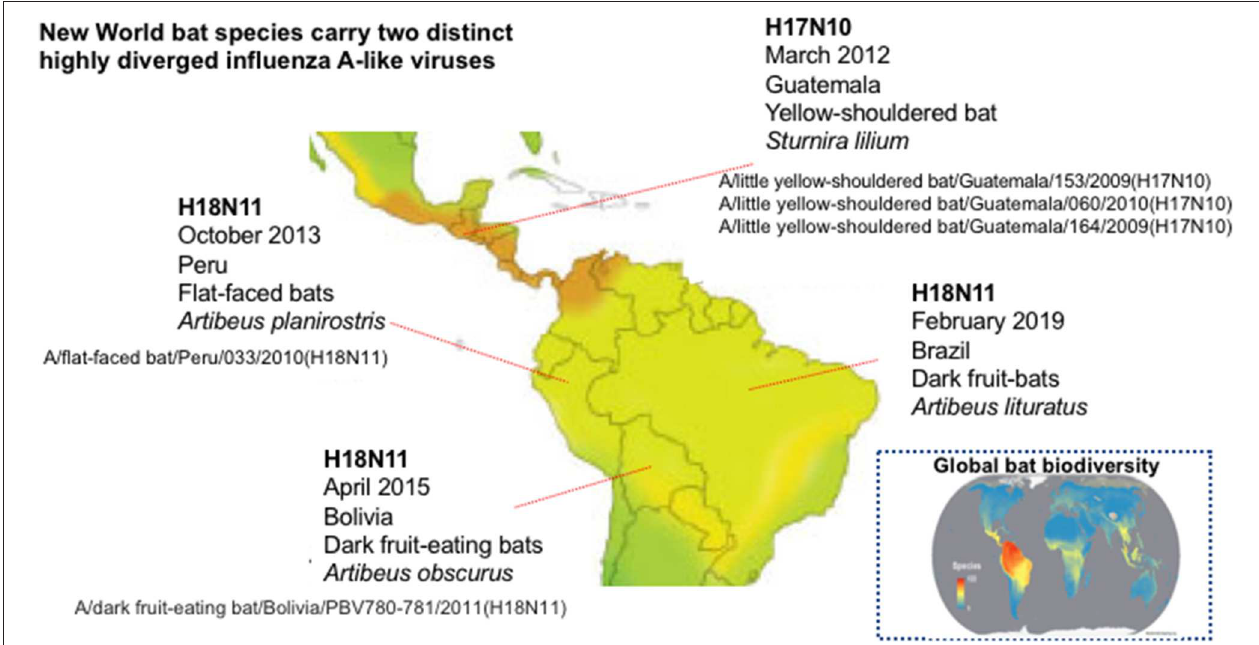
FIGURE 1 | Countries of Central and South America where bat influenza A viruses have been reported. Map showing the global pattern of bat species richness was provided by Clinton Jenkins (see BiodiversityMapping.org) using species data from The IUCN Red List of Threatened Species (2018; https://www.iucnredlist.org) (Jenkins et al.,